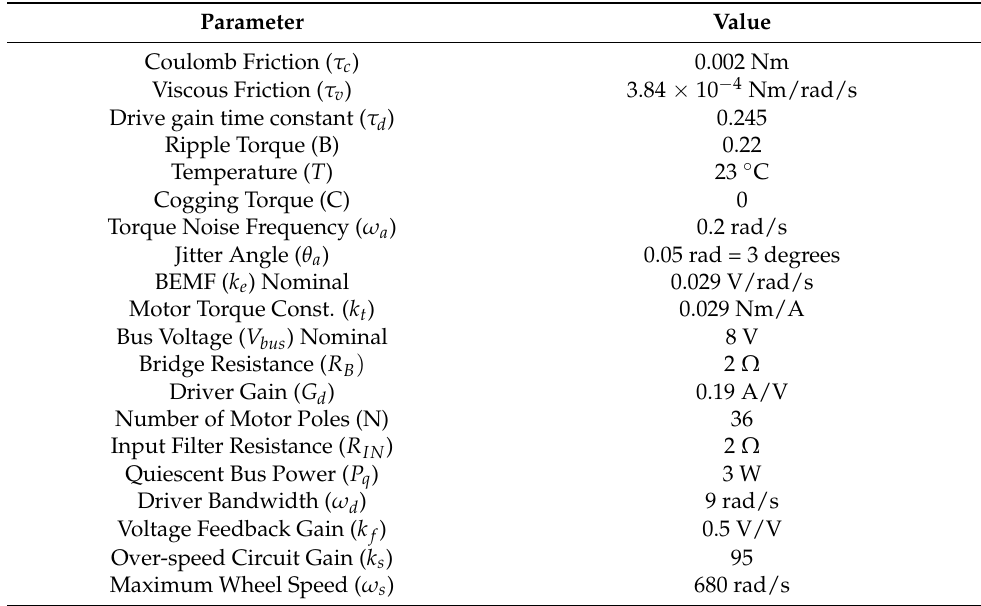
Table 1. ITHACO Type-A reaction wheel model